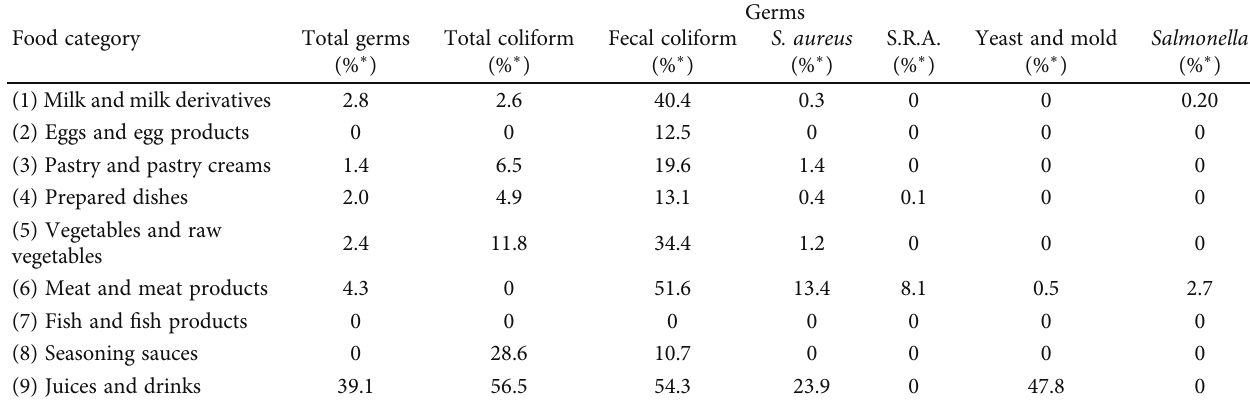
Table 2: Percentage of non-compliance for each food category by